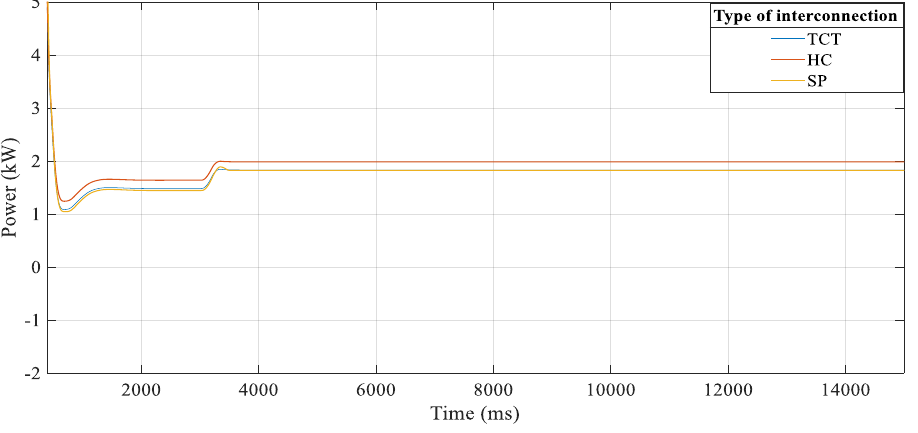
Figure 26. Impact of multiple faults ‘F4′ on the power grid (thin-film PV). Table 10. Comparison of adopted interconnections in PV